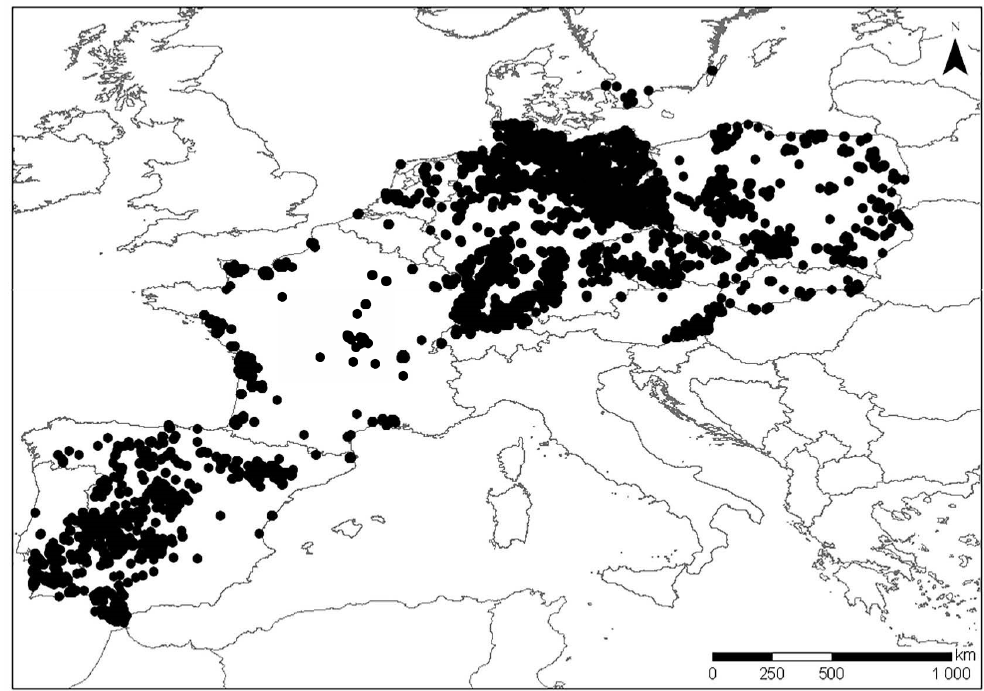
Figure 1. Spatial distribution of the White Stork ringing locations considered in the analysis (1960 to 2009; n =